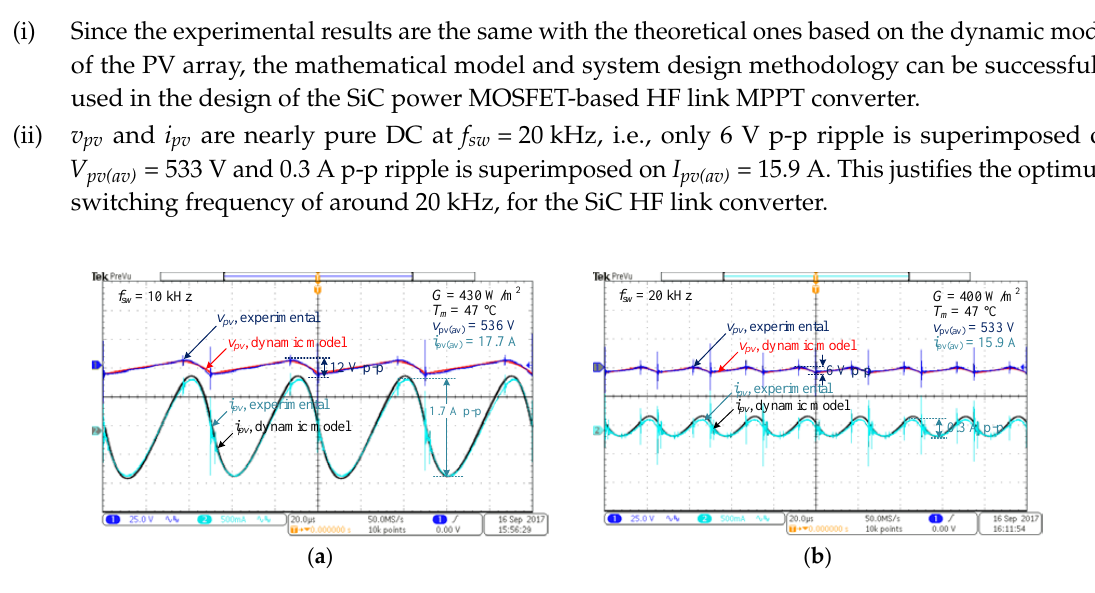
Figure 19. Variations in ac components of v pv and i pv while the MPPT converter supplied from multi-string PV system in Figure 2 is operating at two different switching frequencies in the steady-state: ( a ) f sw = 10 kHz; and ( b ) f sw = 20 kHz. ( v pv and i pv are as defined in Figure 3a. Theoretical results have been obtained for the dynamic model in Figure 5b; v pv and i pv are recorded by using Tektronix MSO3034 oscilloscope, Tektronix P5205A high voltage differential probe, Tektronix TCP404XL current probe and Tektronix TCPA300 current probe